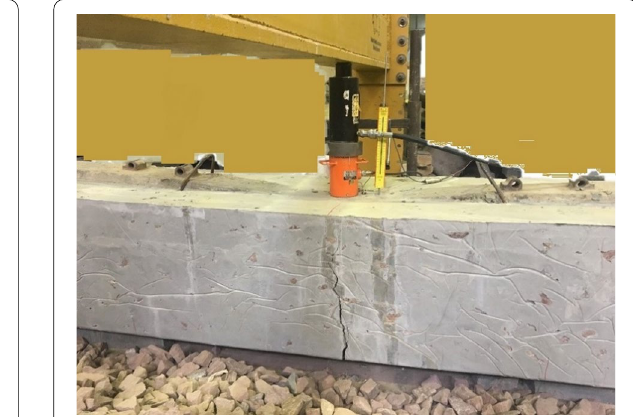
Fig. 17 Failure of PAC before sleeper failure.